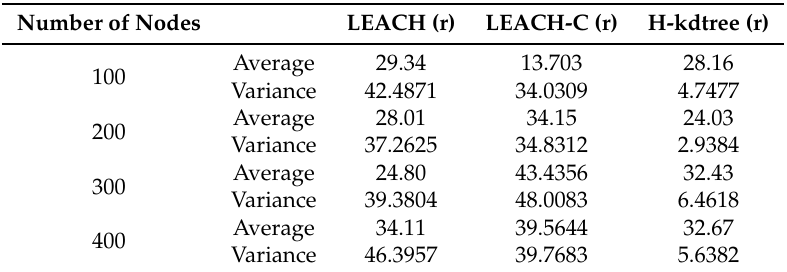
Table 10. Number of cluster head. (r) random.